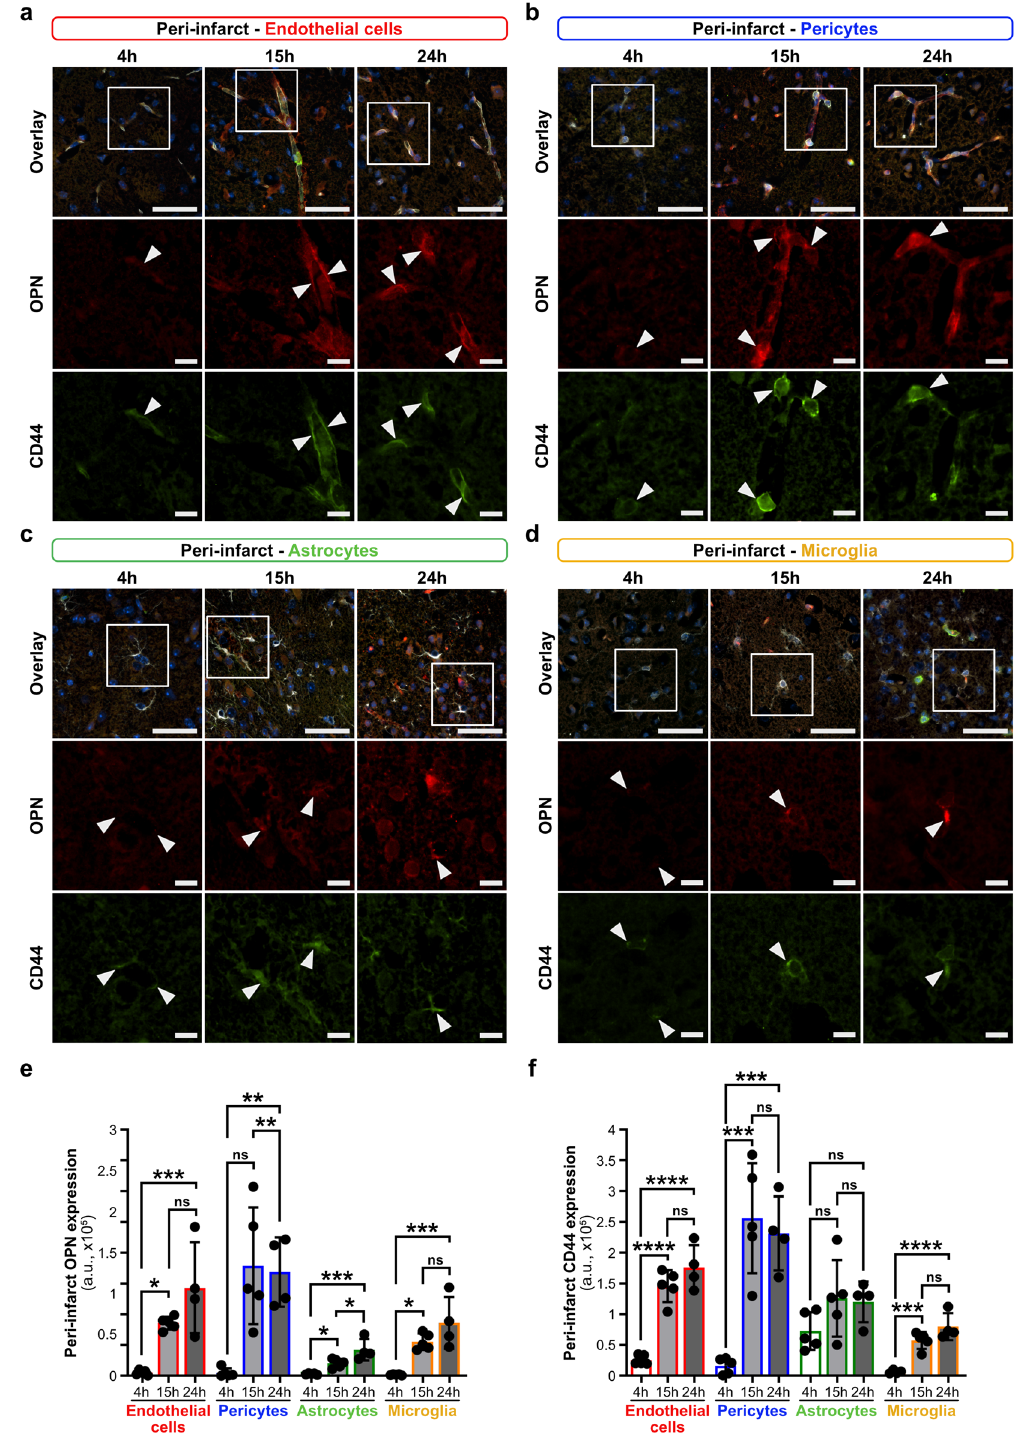
Figure 1. Time course of osteopontin and CD44 receptor expression in peri-infarct NVU cells in mice post- acute ischemic stroke. ( a – d ) Representative images of immunofluorescence staining for osteopontin (OPN, red, inset), CD44 receptor (green, inset) and cell-specific markers (white, overlay) including podocalyxin for endothelial cells ( a ), CD13 for pericytes ( b ), GFAP for astrocytes ( c ) and IBA1 for microglia/macrophages ( d ) in the peri-infarct region of mice 4 h (early acute phase), and 15 h and 24 h (late acute phase) post-stroke. White arrowheads indicate osteopontin and CD44 receptor expressing NVU cells. ( e , f ) Quantification of osteopontin and CD44 receptor expression intensity (arbitrary unit, a.u.) in peri-infarct NVU cells at indicated time points utilizing 3 images/region/animal, n = 5 (4 h), n = 5 (15 h) and n = 4 (24 h); *P < 0.05, **P < 0.01, ***P < 0.001, and not significant (ns) P > 0.05 by one-way ANOVA with Tukey’s multiple comparisons test. Scale 50 µm, 10 µm in insets ( a – d